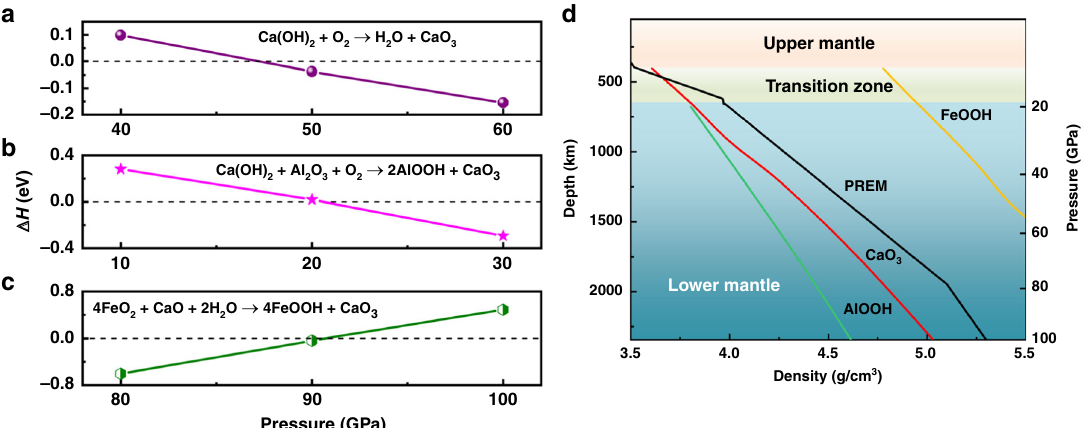
Fig. 4 Phase equilibria and the density of minerals related to production of CaO 3 . a – c Relative enthalpy of proposed reactions forming CaO 3 at high pressure. d Comparison of the density of FeOOH, AlOOH, and CaO 3 with that of Earth ’ s mantle according to the Preliminary Reference Earth Model (PREM)